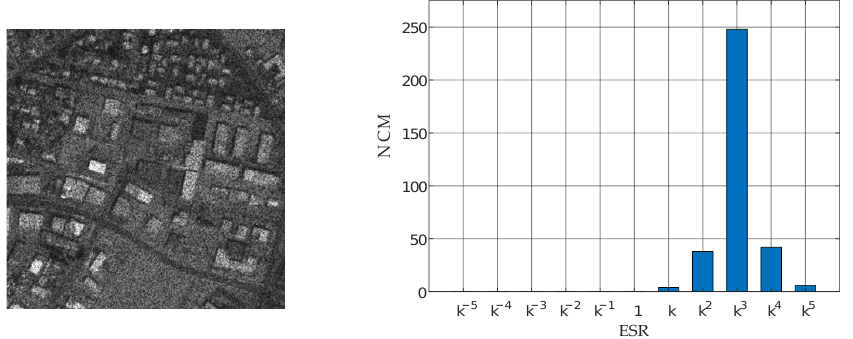
Figure 10. The relationship between scale estimation and NCM.